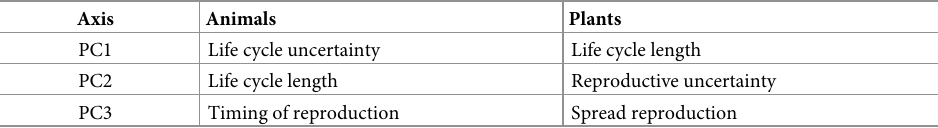
Table 3. Summary of the three main life-history axes for animals and